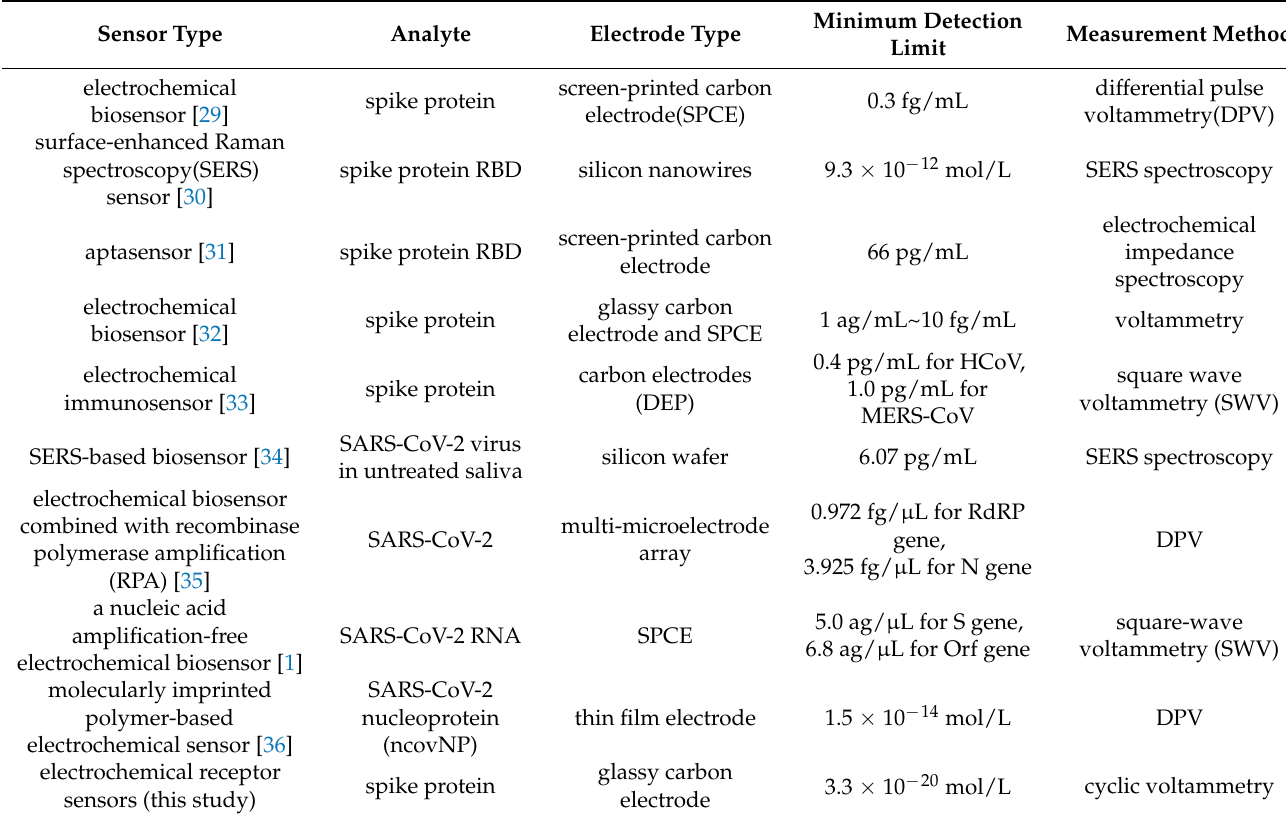
Table 3. Electrochemical sensor based on SARS-CoV-2 detection with spike